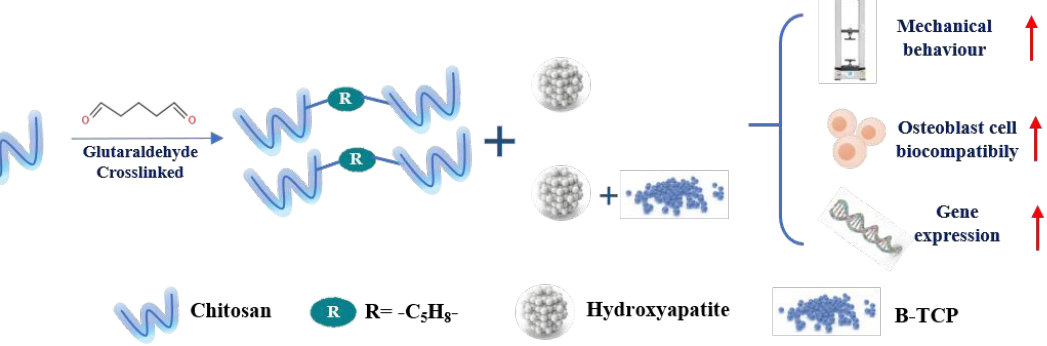
Figure 2. Scheme of developing and characterizing the composite scaffolds by combining biomimet- ically synthesized HAp nanocrystals in the presence of natural biomolecules.